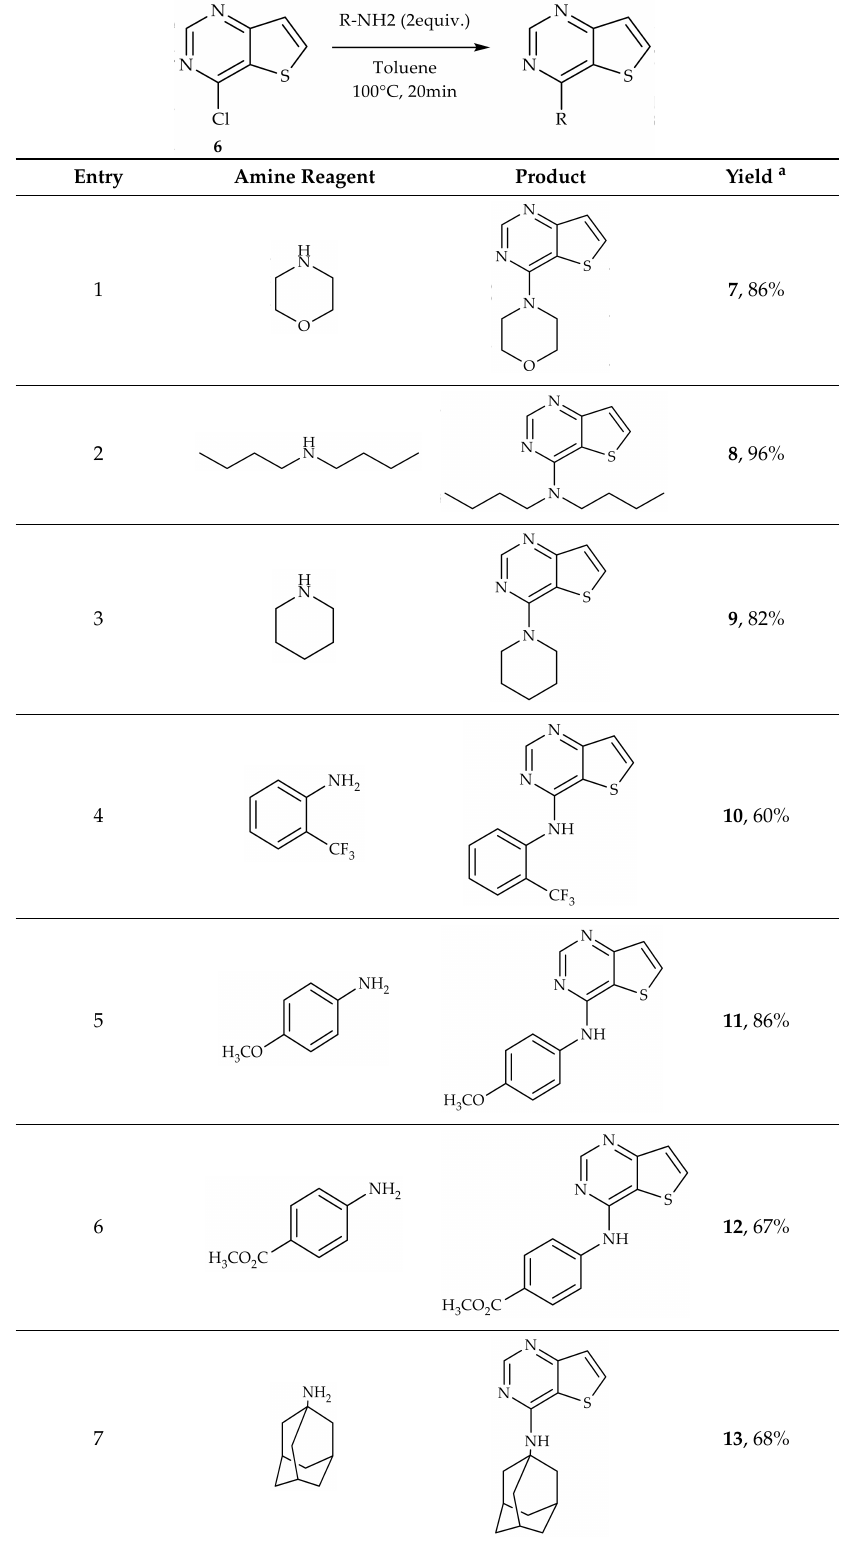
Table 2. SnAr substitution of chlorine on the six-membered ring by various